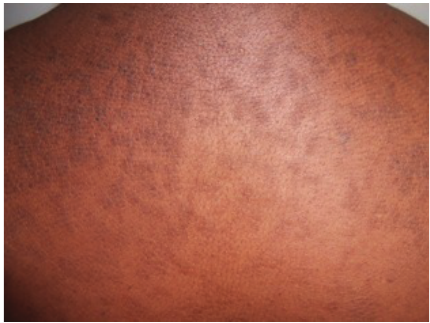
Figure 3: Flat papular lesions in the pectoral region.